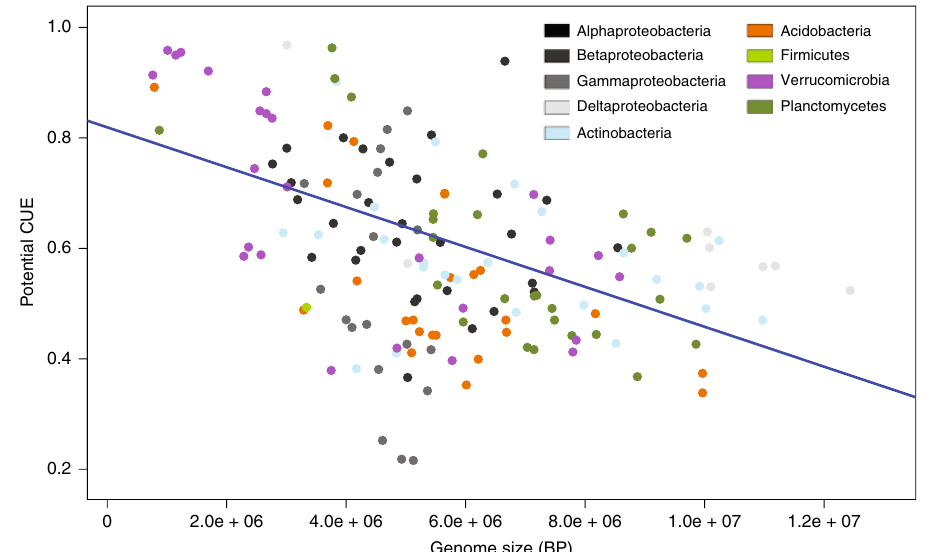
Fig. 5 Potential CUE versus genome size. Potential CUE regressed against genome size (bp). Blue lines show GLS fi t. Points are colored by